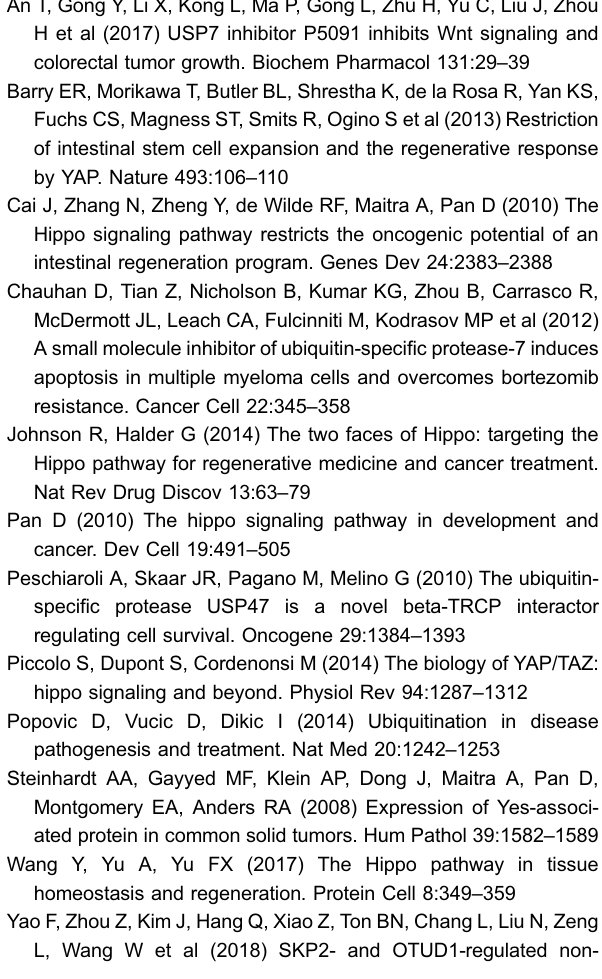
b Figure 2. USP47-regulated stabilization of YAP is involved in the development of CRC . (A) Elevated USP47 and YAP protein expression in CRC specimens. USP47 and YAP expression were determined by IHC. (B) USP47 protein levels were higher in in tumors bigger than 15 mm 3 . (C) YAP and USP47 protein expression in CRC specimens were positively correlated. (D and E) Overexpression of YAP rescued USP47 knockdown-induced inhibition of cell proliferation. (F) USP47 inhibitor P5091 decreases YAP protein expressions in HCT116 and HT29 cells. USP47, YAP and actin protein expressions were determined following P5091 treatment. (G) USP47 inhi- bitor P5091 suppressed HCT116 and HT29 cells growth and the inhibition was reversed by YAP overexpression. The data are presented as the means ± SD from triplicate